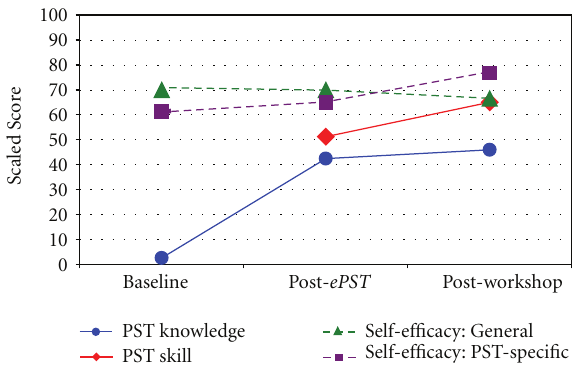
Figure 1: Scaled scores for skill, knowledge, and self-e ffi cacy. Scaled Score = Median converted to percent of maximum possible